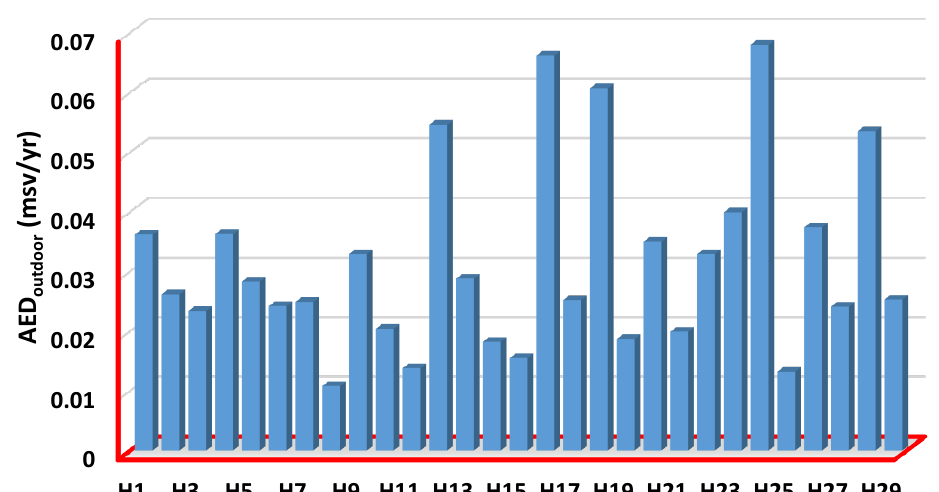
Figure 6. Outdoor annual effective doses (AED outdoor ) for all herbs.